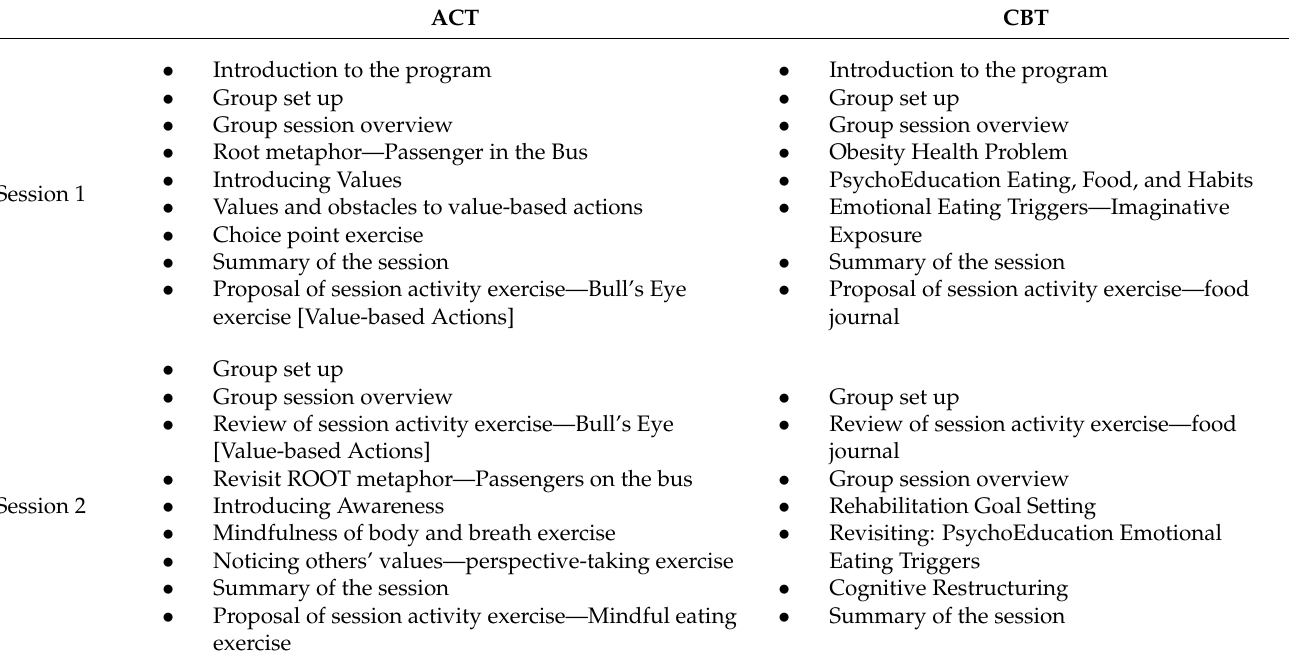
Figure 1. SPIRIT checklist illustrating the study procedures. Table 1. Contents of ACT and CBT group